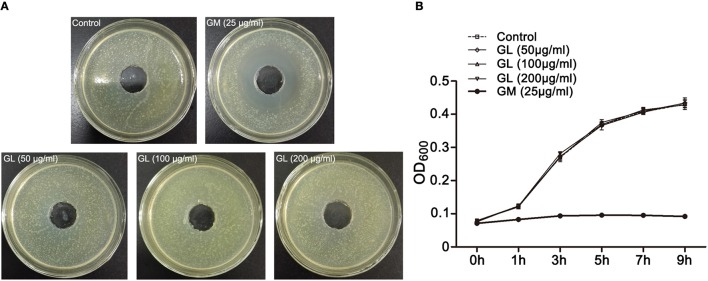
In vitro antibacterial activity of GL against ST. (A) ST (1 × 108 CFU/mL) were cultured in LB agar medium and treated with various concentrations of GL (0, 50, 100, 200 μg/ml), and GM (25 μg/ml) was used as a positive control at 37°C. The size of the inhibition zone was observed (B) and analyzed statistically with a line chart. The OD600 kinetics were determined to analyze the effect of GL against ST.